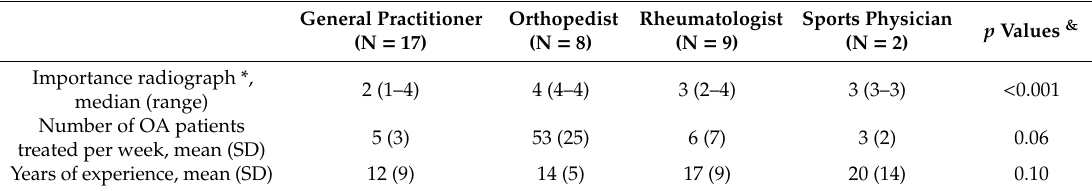
Table 1. Expert characteristics.